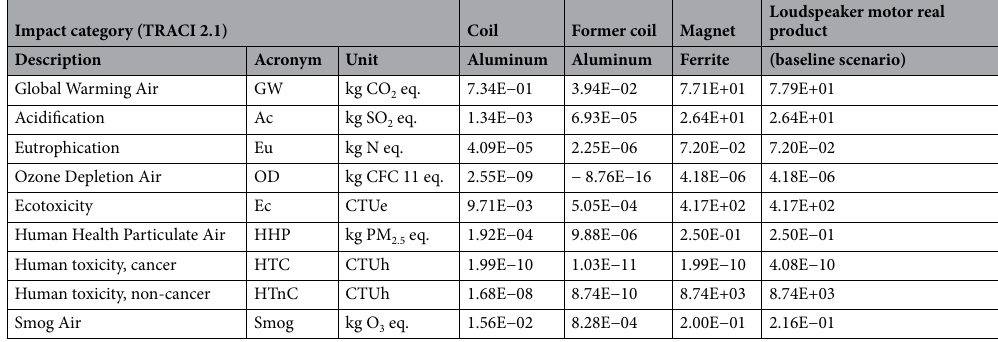
Table 2. Life Cycle Assessment results of baseline scenario